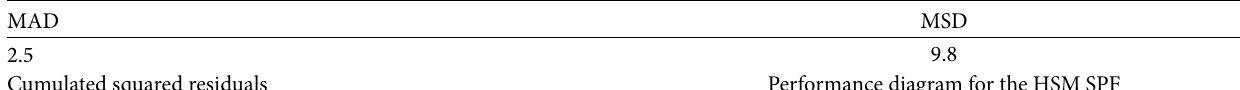
Cumulated squared residuals Performance diagram for the HSM